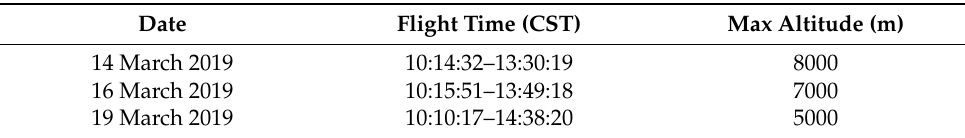
Figure 2. The experimental site for aircraft-based measurements of CO 2 and the flight paths on ( a ) 14 March ( b ) 16 March, and ( c ) 19 March 2019 over Qinhuangdao, China. The yellow points show the satellite observations near the study area. Table 1. Details of flight on each day.